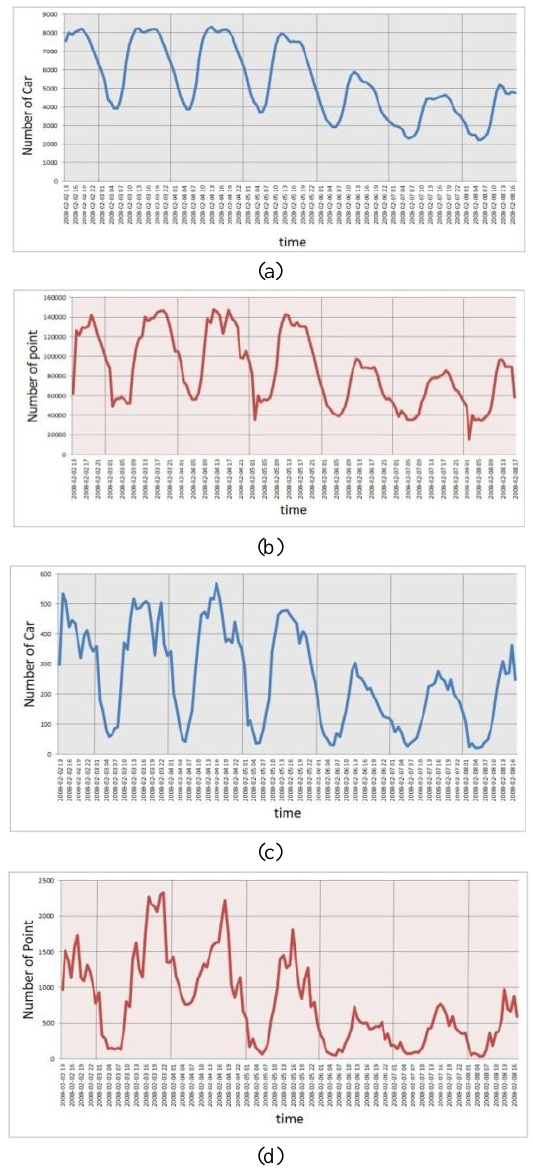
Figure 5. The visualization results of spatiotemporal aggregation